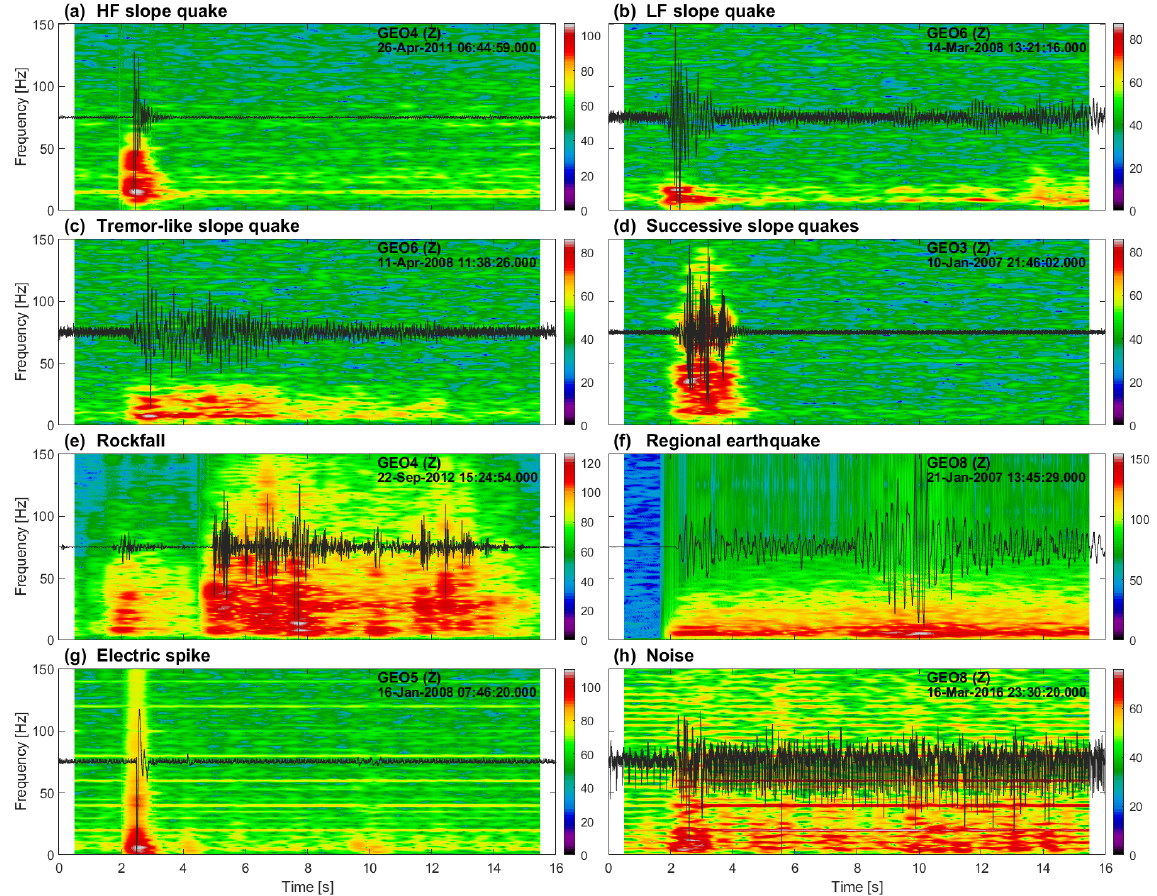
Figure 2. Spectrograms and normalized waveforms of the maximum-amplitude record of signals representative of each class: (a) HF slope quake, (b) LF slope quake, (c) tremor, (d) successive slope quakes, (e) rockfall, (f) regional earthquake, (g) spike, and (h) noise. Note that colour scales are in a logarithmic scale [dB] and not normalized. Frequencies are only shown up to 150Hz. In (f) , both the P- and S-wave arrivals are visible at ca. 2 and 8s, respectively. Vertical component waveforms of the example events recorded at all geophones are displayed in the Appendix (Figs. B1 to